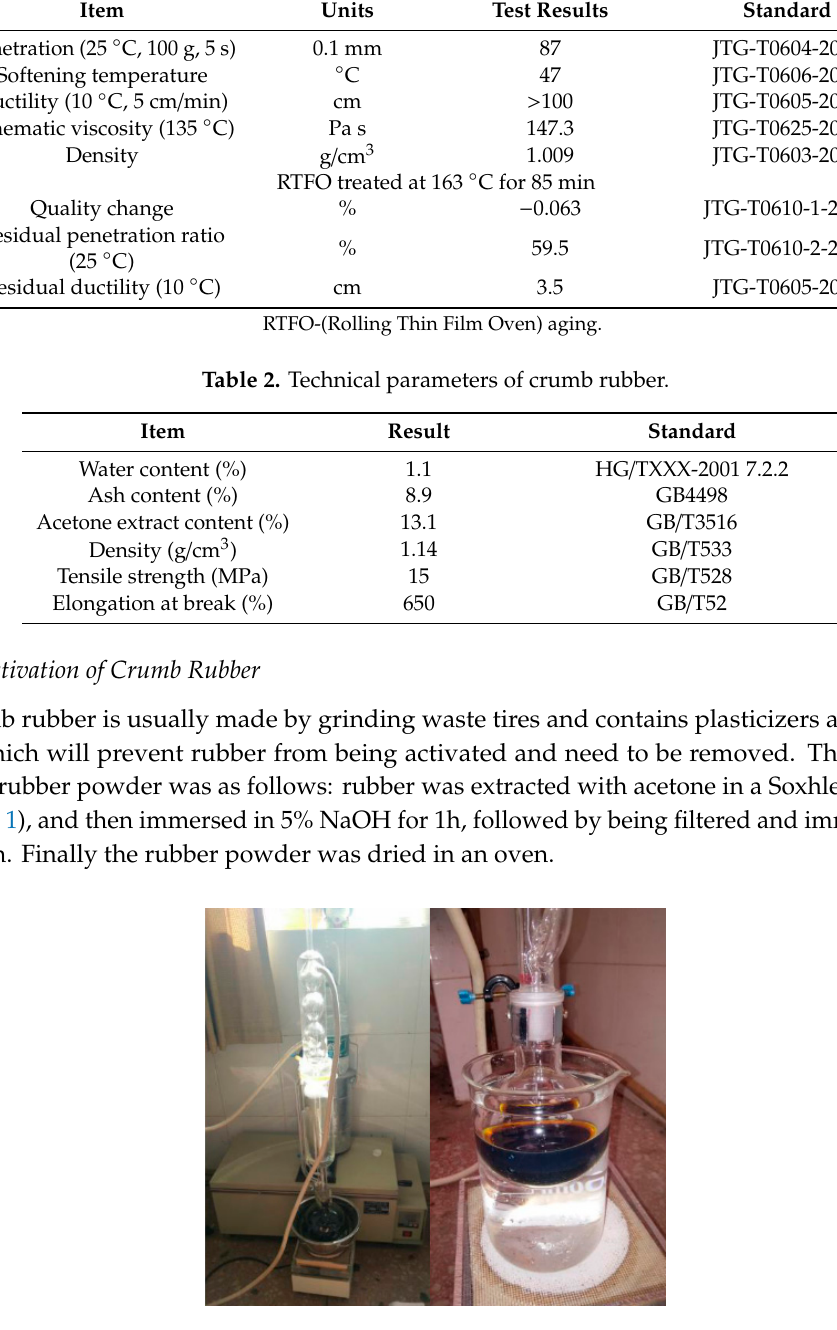
Figure 1. Purification of crumb rubber.